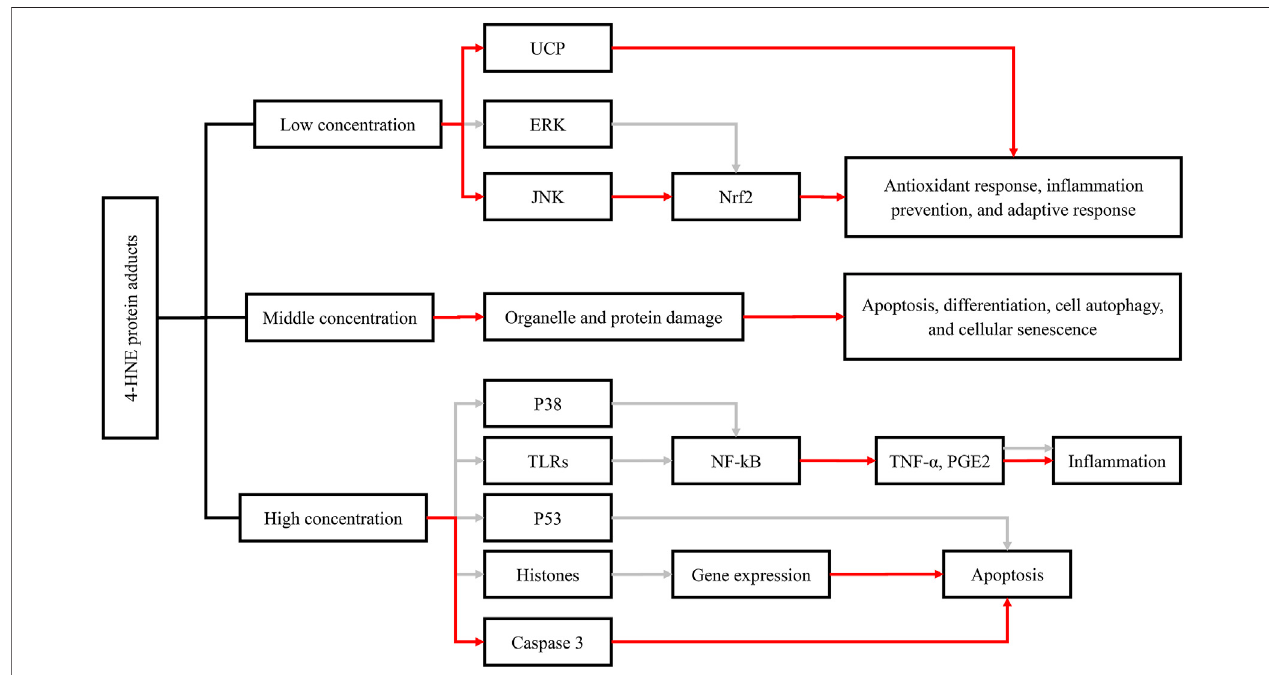
FIGURE 1 | Functions of 4-HNE-protein adduct formation and their effects on cellular metabolic pathways, including the antioxidant response, in fl ammation, and apoptosis. The red arrow represents activation; the gray arrow represents inhibition. Abbreviations: 4-HNE, 4-hydroxynonenal; UCP, uncoupling protein; ERK, extracellular signal – regulated kinase; JNK,c-Jun N-terminalkinase; NF κ B, nuclear factor kappa B;Nrf2,nuclear factor (erythroid-derived 2)-like 2;p38, protein 38; p53, protein 53; TLRs, toll-like receptors; TNF- α , tumor necrosis factor- α ; PGE2, prostaglandin E.